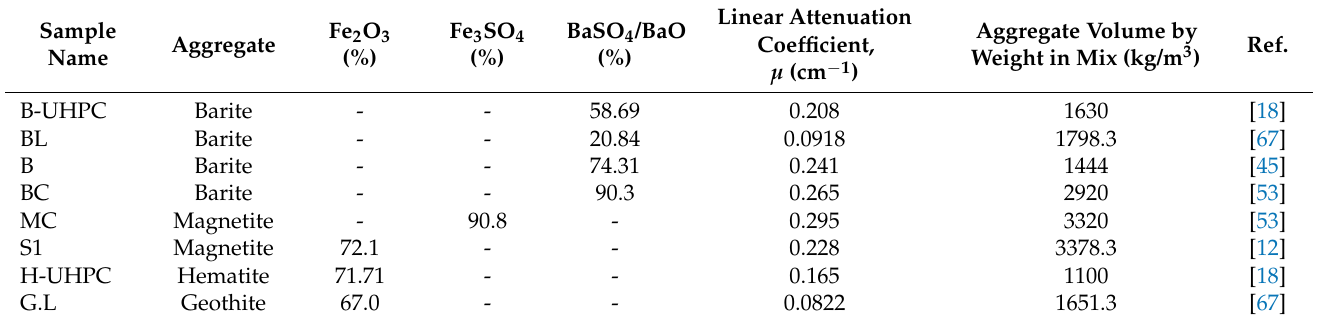
Table 3. List of samples with major comprising elements from reviewed